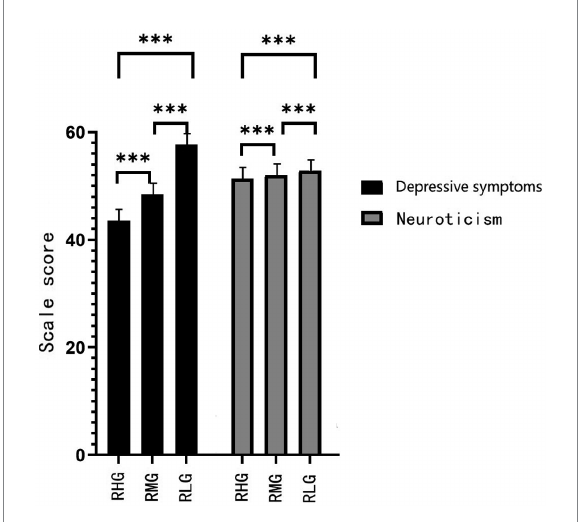
FIGURE 1 Comparison of scores on depressive symptoms and neuroticism in RHG, RMG and RLG. Data are expressed as means ± standard error of the mean (SEM). *** p <